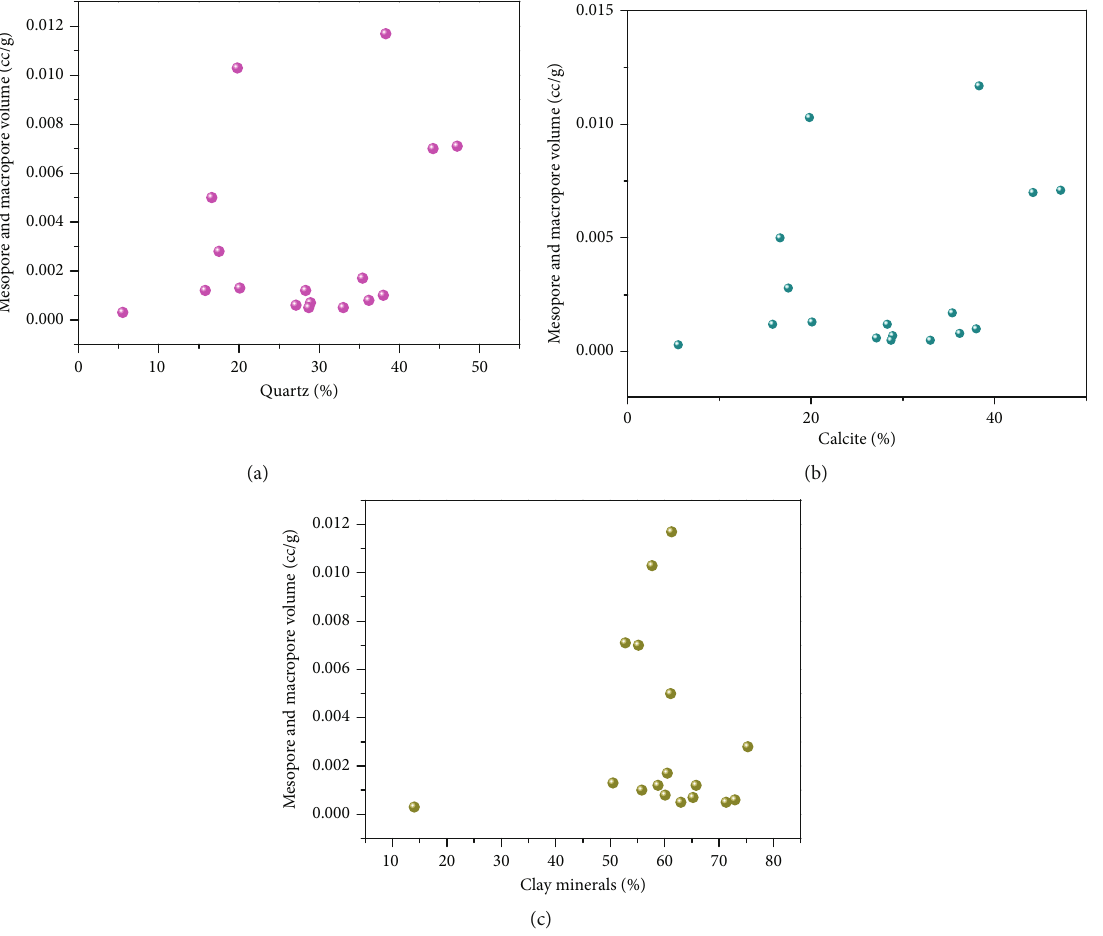
Figure 10: Shows the plot correlations between meso-macropore volume versus di ff erent minerals in the Shanxi Formation and Taiyuan Formation: (a) plot correlation between meso-macropore volume versus quartz, (b) plot correlation between meso-macropore volume versus calcite, and (c) plot correlation between meso-macropore volume versus clay minerals in the Shanxi Formation and Taiyuan